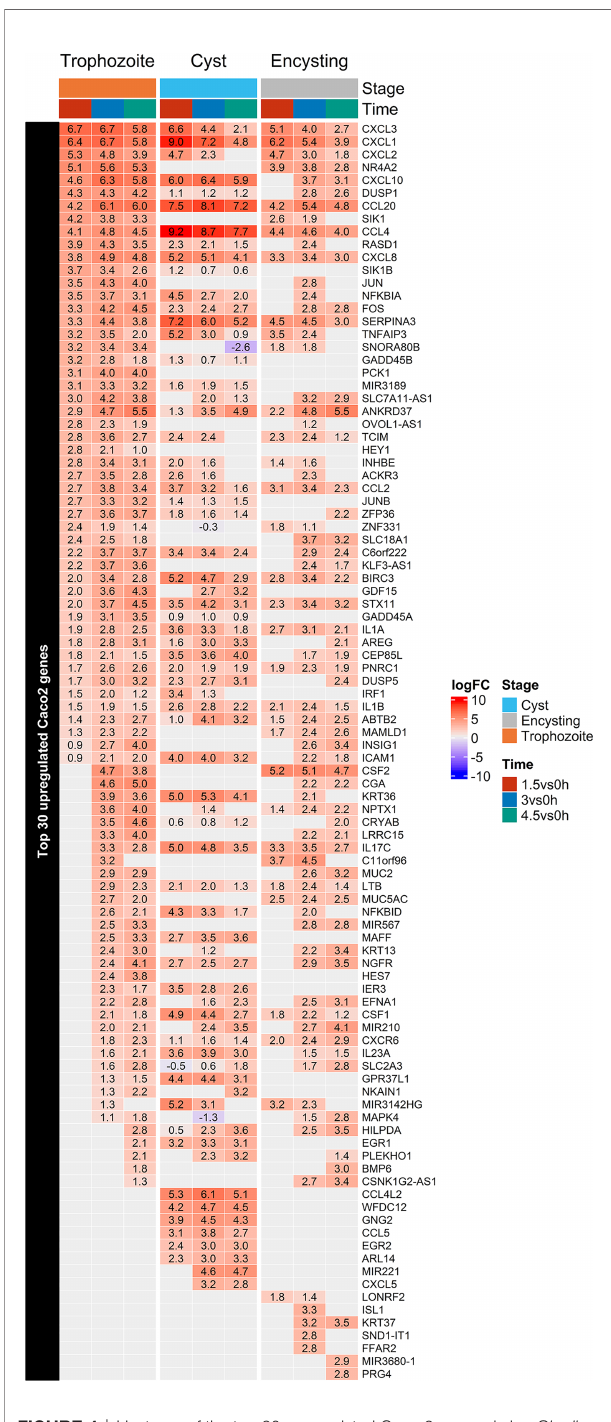
FIGURE 4 | Heatmap of the top 30 up-regulated Caco-2 genes during Giardia trophozoite, cyst and encysting cells infections in each of the infection timepoints, 1.5, 3, and 4.5h. Only signi fi cant values are shown, insigni fi cant values are set